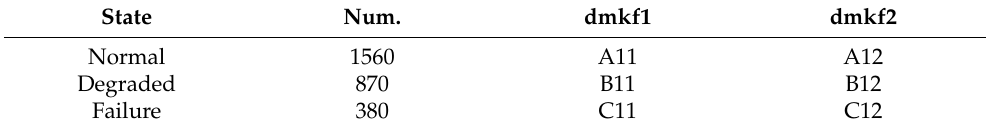
Table 1. Comparison of the fault diagnosis results utilizing dmkf1 and dmkf2. State Num. dmkf1